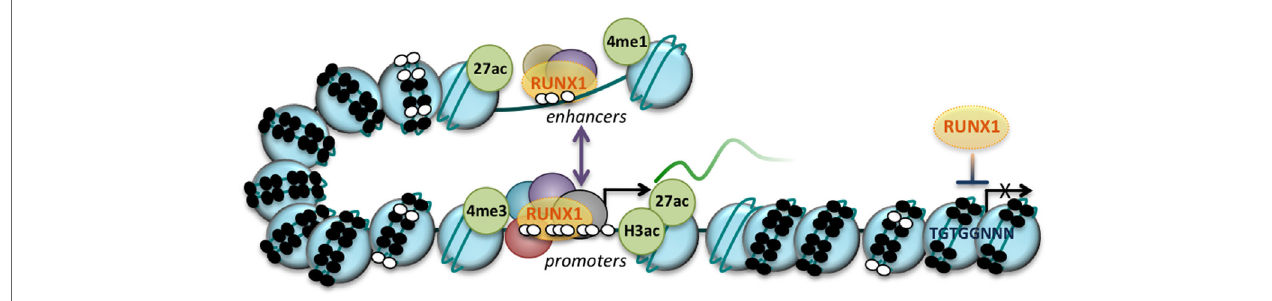
FiGURe 1 | RUnX1 regulates gene expression at both the transcriptional and epigenetic level . RUNX1 binding to promoters and enhancers is regulated by the chromatin structure encompassing its binding sites (TGTGGNNN, as indicated), with condensed chromatin (nucleosomes, large blue circles) acting as a barrier to RUNX1 binding. DNA methylation (small black circles) may further inhibit RUNX1 binding. RUNX1 binds in a complex with other transcriptional regulators and coactivators/ corepressors (represented by purple, red and green circles) at regions of open chromatin (nucleosome-depleted regions), which can impact gene expression through interactions with the transcription machinery or by modifying chromatin structure and composition. At enhancers, RUNX1 binding is accompanied by active histone marks, histone 3 lysine 27 acetylation (27ac), and histone 3 lysine 4 monomethylation (4me1) while at promoters, RUNX1 binding is associated with histone 3 lysine 3 trimethylation (4me3), histone 3 acetylation (of lysine 9 and 14; H3ac), and histone 3 lysine 27 acetylation (27ac). These active gene regulatory elements may interact through DNA loops (purple bidirectional arrow) and are devoid of DNA methylation (small white circles). Arrow, transcriptional start site